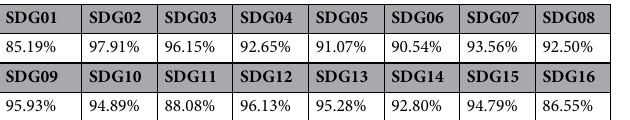
Table 1. SDG hashtags used by validated users over their usage in the entire dataset. These high percentages indicate that most active users using SDG hashtags are validated by the filtering procedure. In turn, it implies that SDGs are among the main subjects shaping the various common narratives of large firm’s accounts on Twitter.